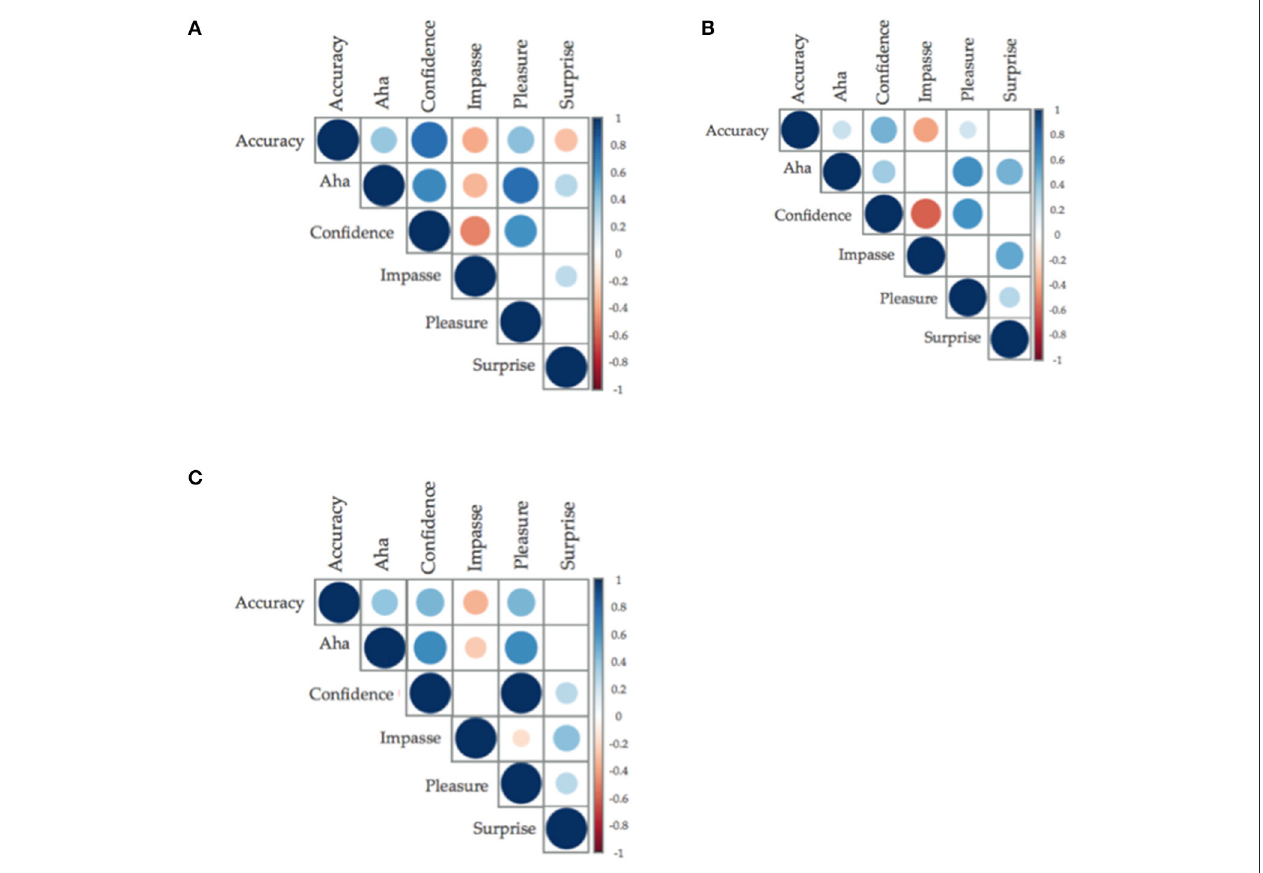
FIGURE 3 | (A–C) Correlation plots between accuracy and insight and insight related affect. Size of the circle and saturation of color determine the strength of the correlation; the color determined the direction of the relationship, with positive being blue ( A : classic insight problems; B : classic non-insight problems; C : compound remote associates. Only relationships with less than p = 0.05 have been